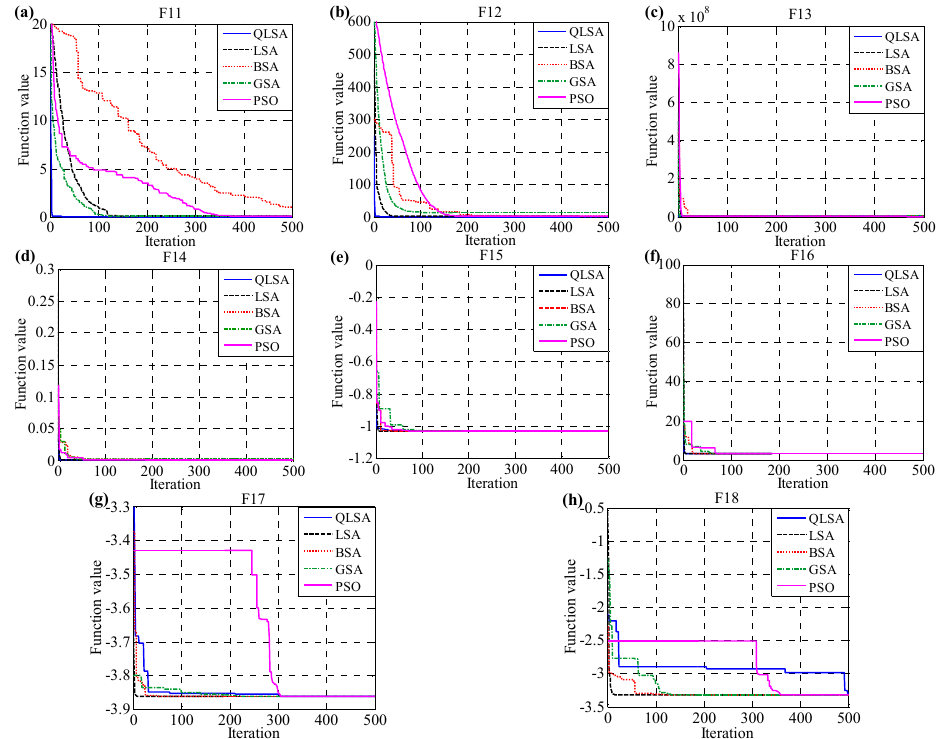
Figure 14. Convergence characteristic curves for QLSA, LSA, BSA, GSA and PSO in: ( a ) F11; ( b ) F12; ( c ) F13; ( d ) F14; ( e ) F15; ( f ) F16; ( g ) F17; ( h ) F18.